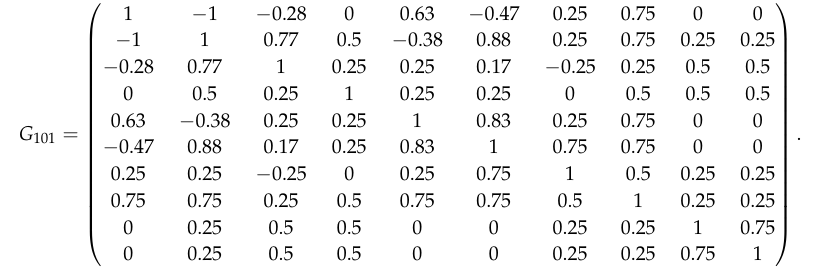
Table 2 sums up the eigenvalues of our seven pseudo-correlation matrices: note that none of the considered matrices is PSD. However, some of them are not very far from having this